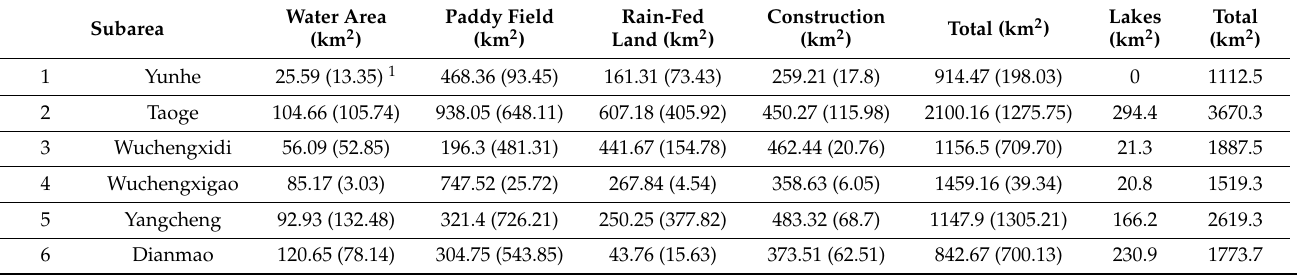
Table 1. The areas of different underlying surfaces of the plain area in Taihu Basin, including outside and inside the polder